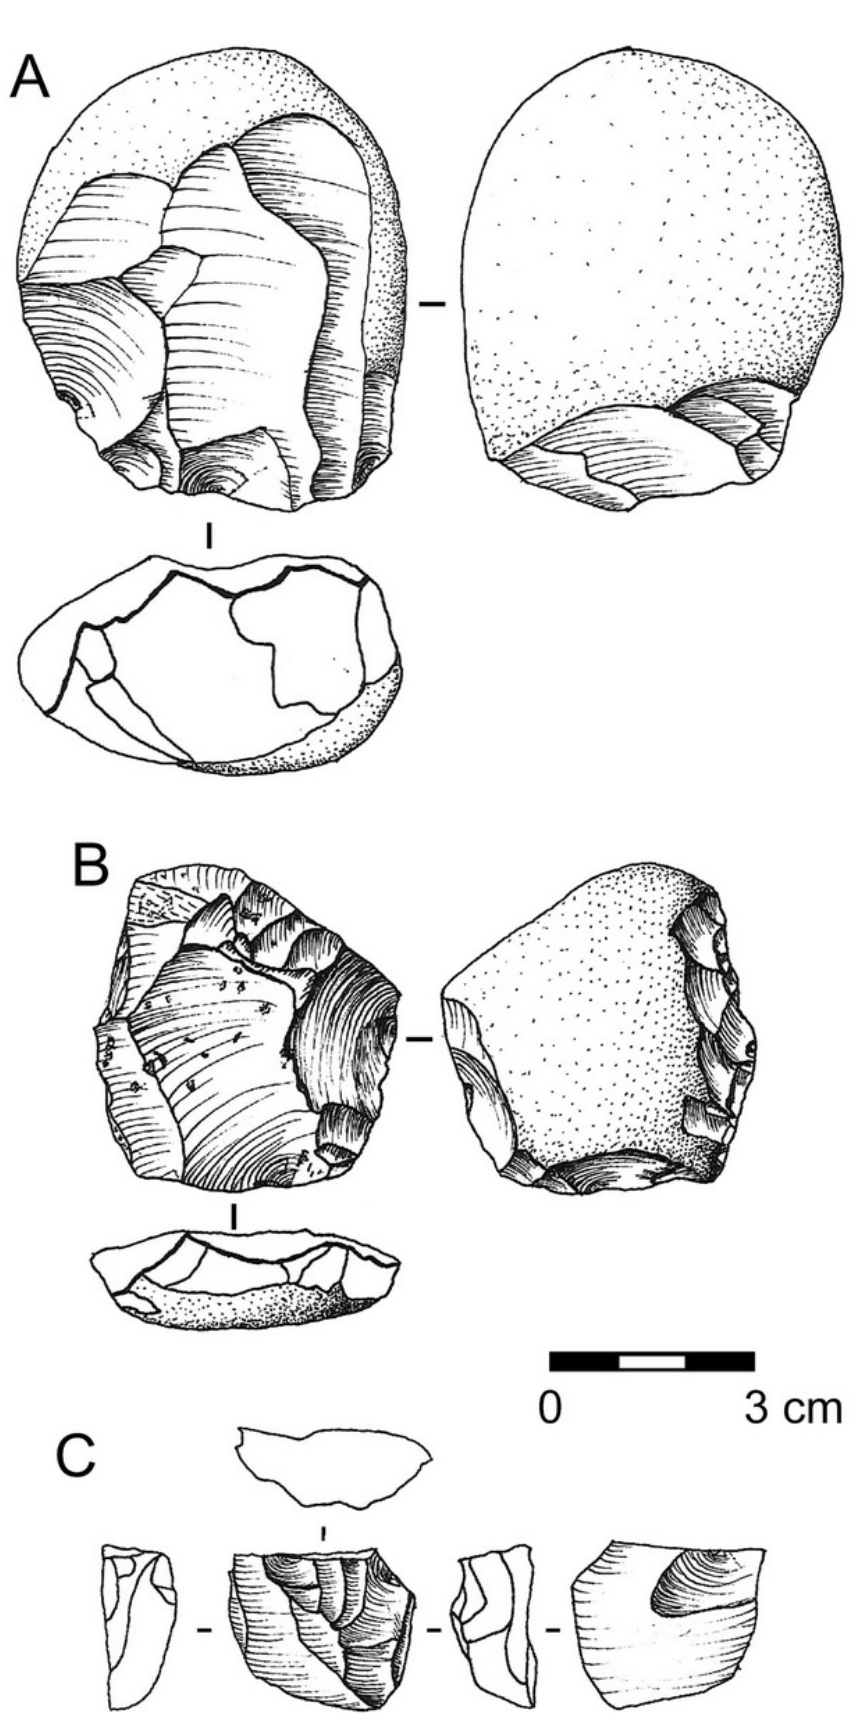
Figure 5. Drawing of cores. A: unipolar Levallois; B: convergent Levallois; C: